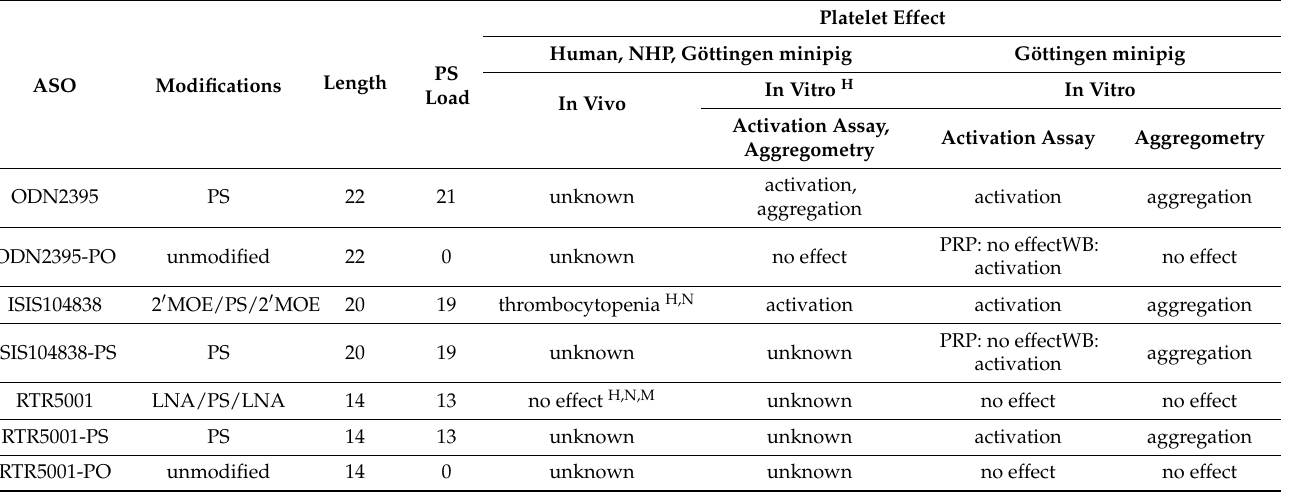
Table 2. Overview of in vivo and in vitro platelet response in Göttingen minipig, NHP, and humans for all the seven different tool ASOs, including the modifications used for each sequence, its length, and PS load